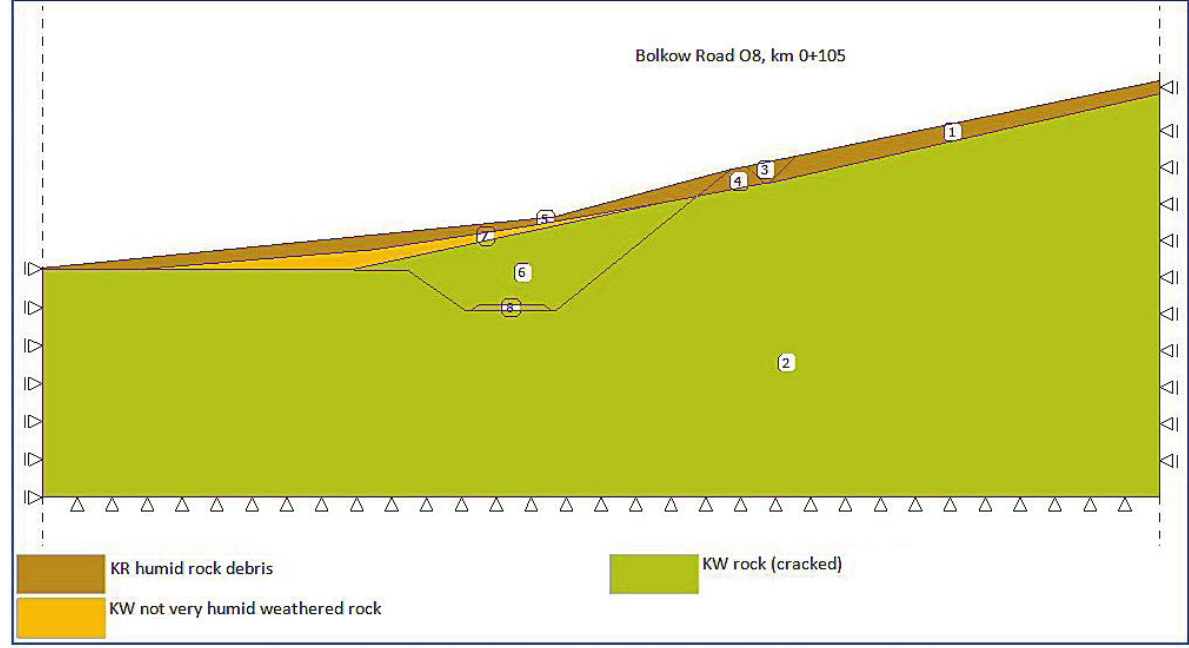
Figure 12. Current profile of the road O8 slope at km 0 + 105.00.